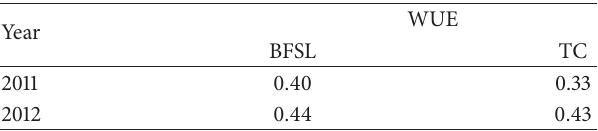
Table 5: Mean WUE at growth stage R1 of 10 irrigated maize hybrids grown on a Bosket fine sandy loam (BFSL) and a Tunica clay (TC) soil in 2011 and 2012 near Stoneville, MS † .